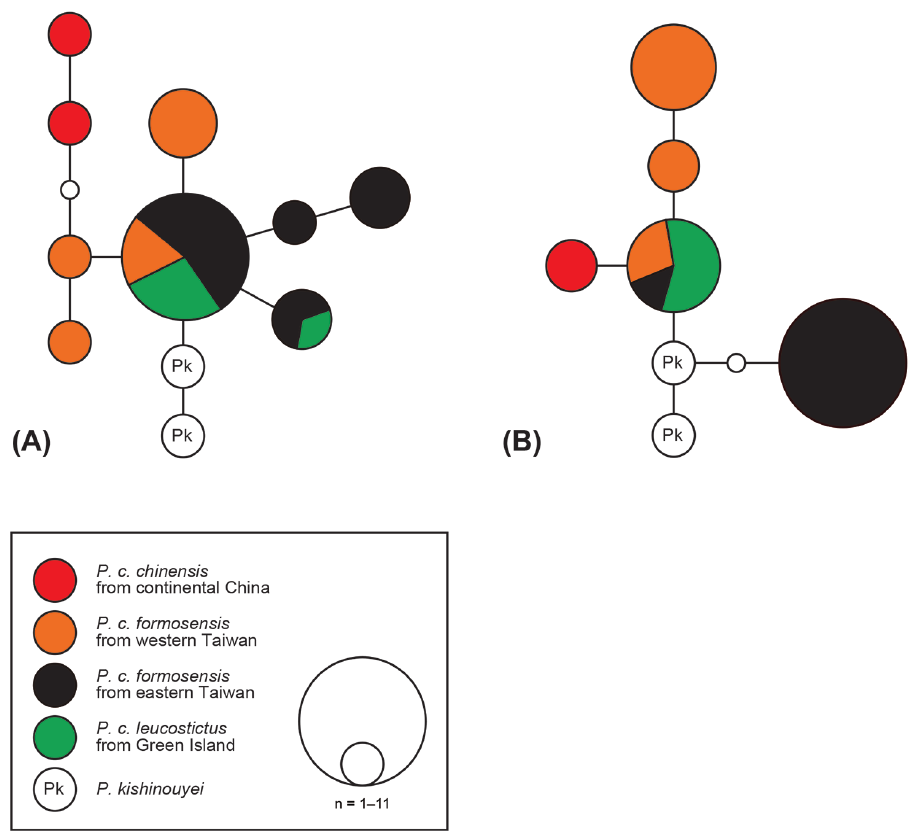
Figure 4. Median-joining networks of the RAG–1 A and PRLR B datasets. Open circles indicate miss- ing